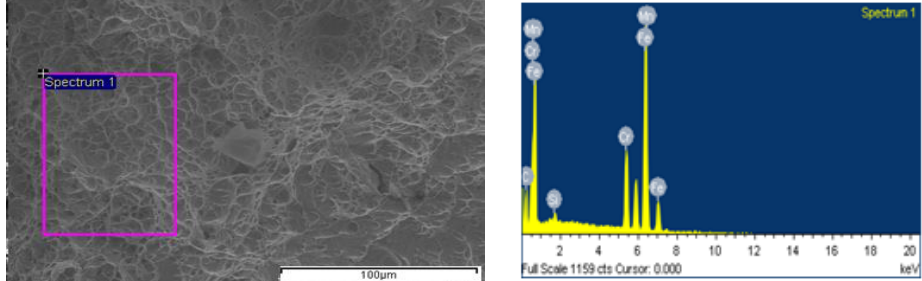
Figure 17. EDS/SEM spectrum analysis of fracture face of TIG weld zone.